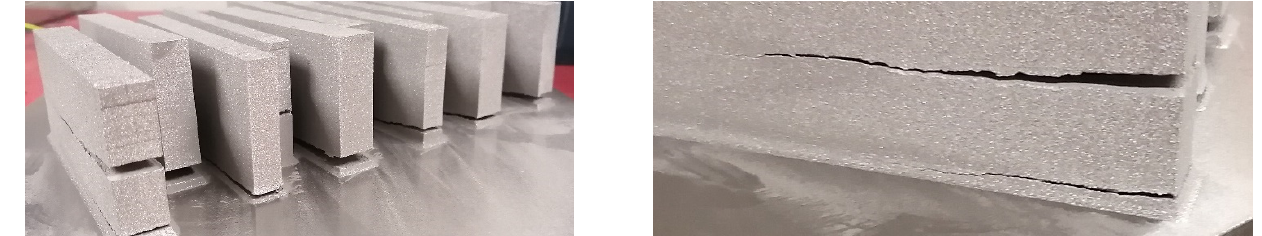
Figure 4. Destructiveness of residual stress due to the temperature gradient [76] (Courtesy of CRPM).